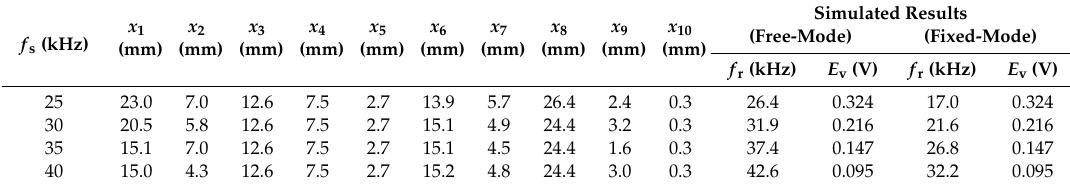
Figure 4. ( a ) Results of resonant frequency f r and electric voltage E v before (black squares) and after (red circles) optimizing epoxy thickness under conditions underlined in Table 1; ( b ) cross-sectional views for corresponding designs. Table 2. Values of optimized design variables shown in Figure 4b and corresponding results on resonant frequency f r and electric voltage E v for free and fixed boundary conditions.